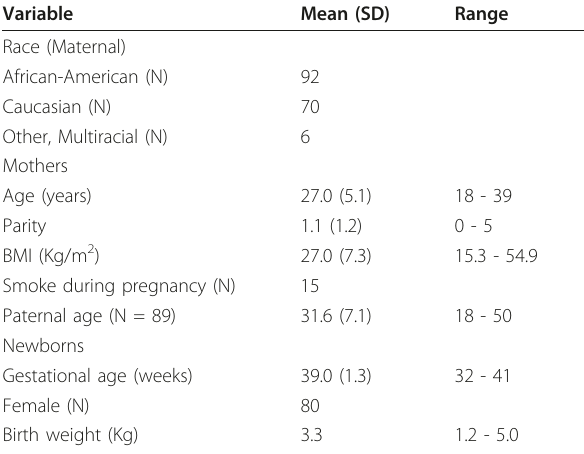
Table 1 Characteristics of the participants (n = 168)